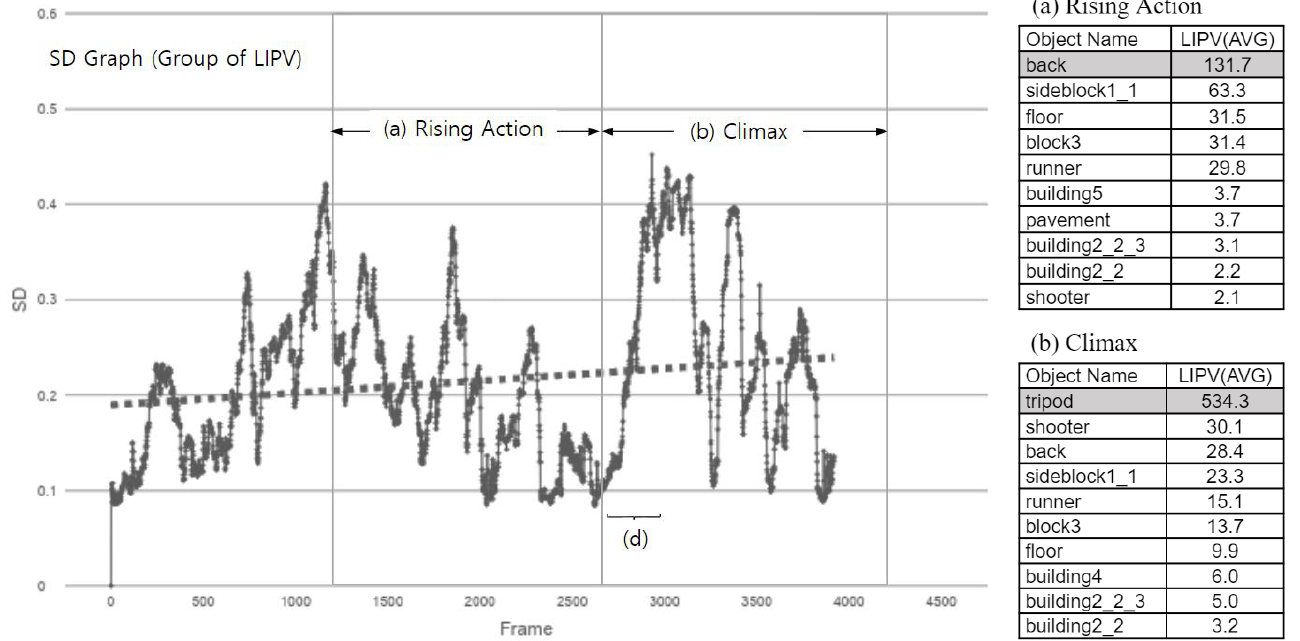
Figure 6. LIPV (low immersion, positive valence) group in the Rising Action and Climax (Standard Deviation ( left ) and Objects Most Seen ( right )).